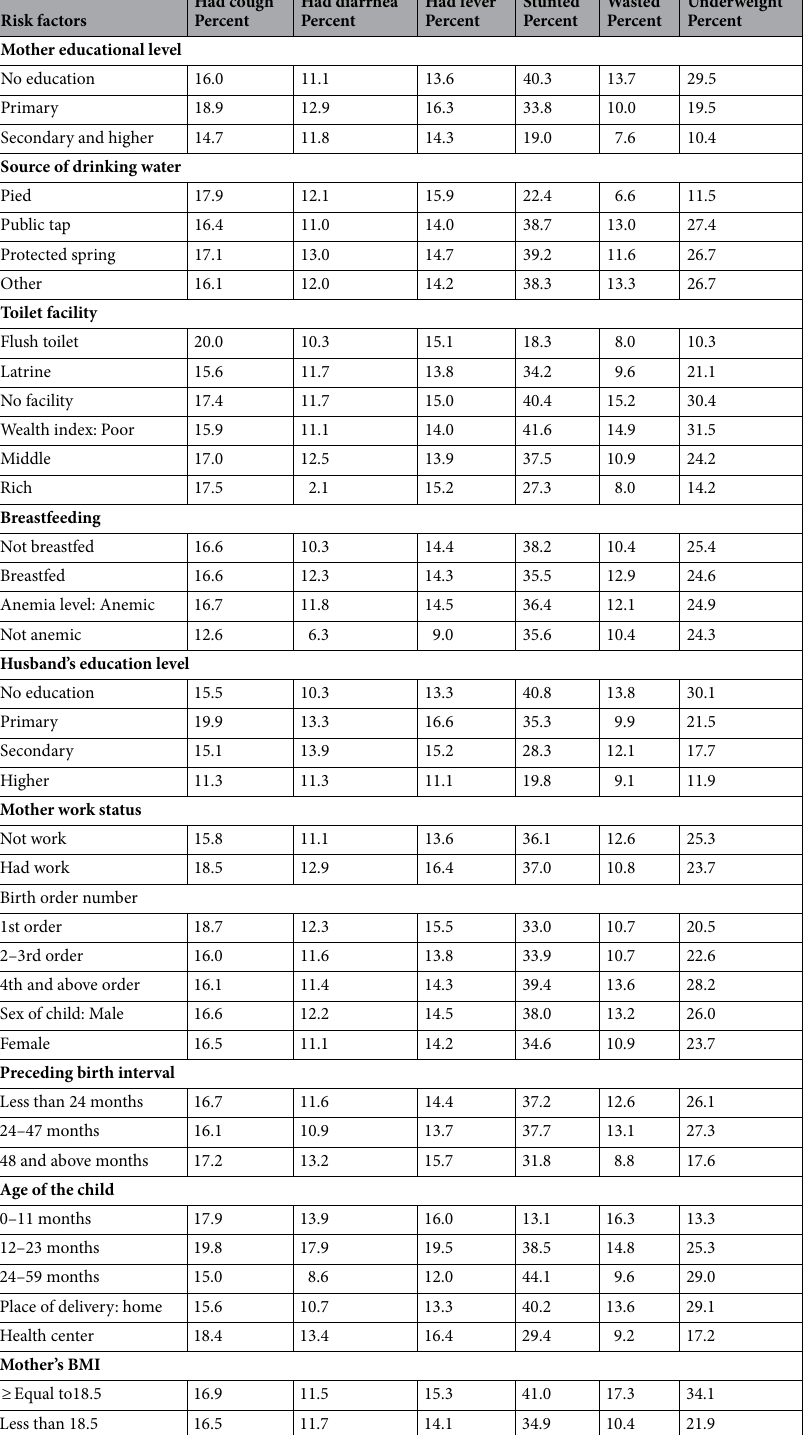
Table 1. Percentage distribution of childhood malnutrition and